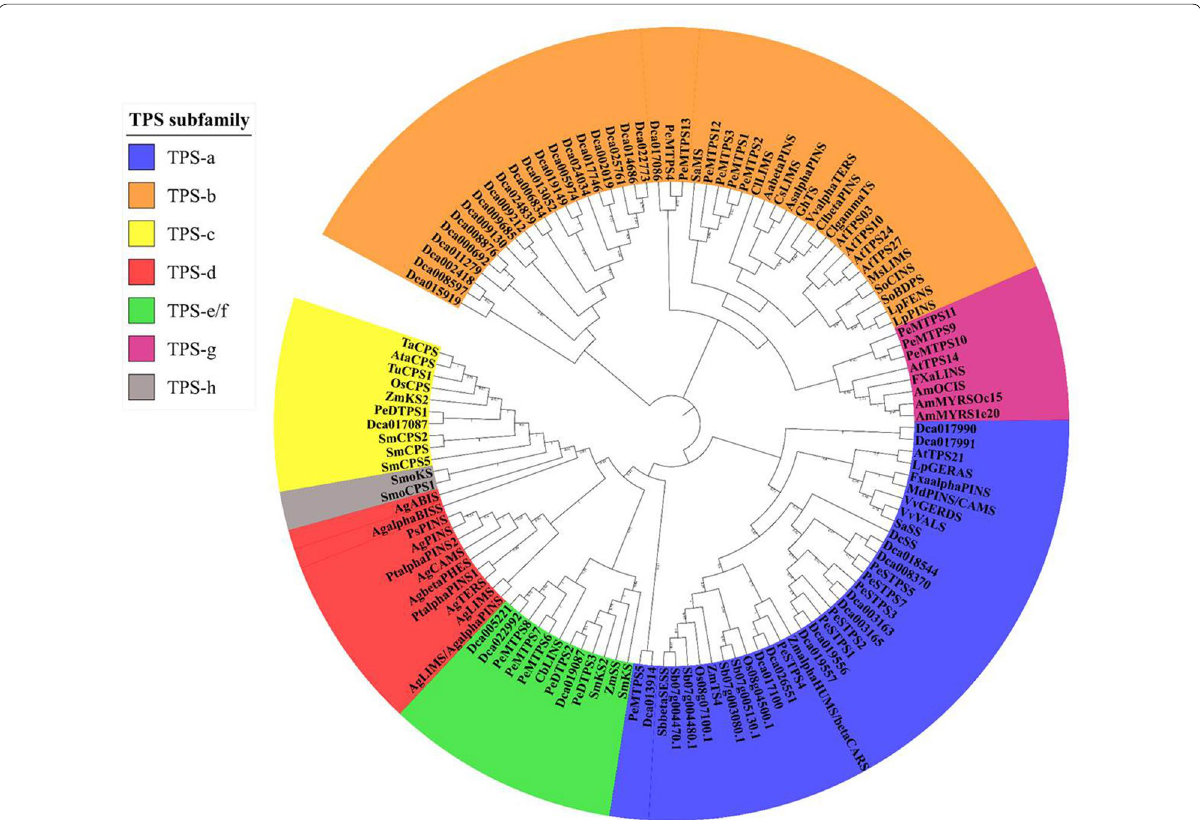
Fig. 3 Phylogeny of P. equestris and Dendrobium catenatum’s TPS subfamily. The evolutionary history was inferred using the Neighbor‑Joining method (Saitou and Nei 1987). The bootstrap consensus tree inferred from 100 replicates (Felsenstein 1985) is taken to represent the evolutionary history of the taxa analyzed (Felsenstein 1985). Branches corresponding to partitions reproduced in less than 50% bootstrap replicates are collapsed. The evolutionary distances were computed using the JTT matrix‑based method (Jones et al. 1992) and are in the units of the number of amino acid substitutions per site. The analysis involved 123 amino acid sequences. All ambiguous positions were removed for each sequence pair. There were a total of 1411 positions in the final dataset. Evolutionary analyses were conducted in MEGA7 (Kumar et al.